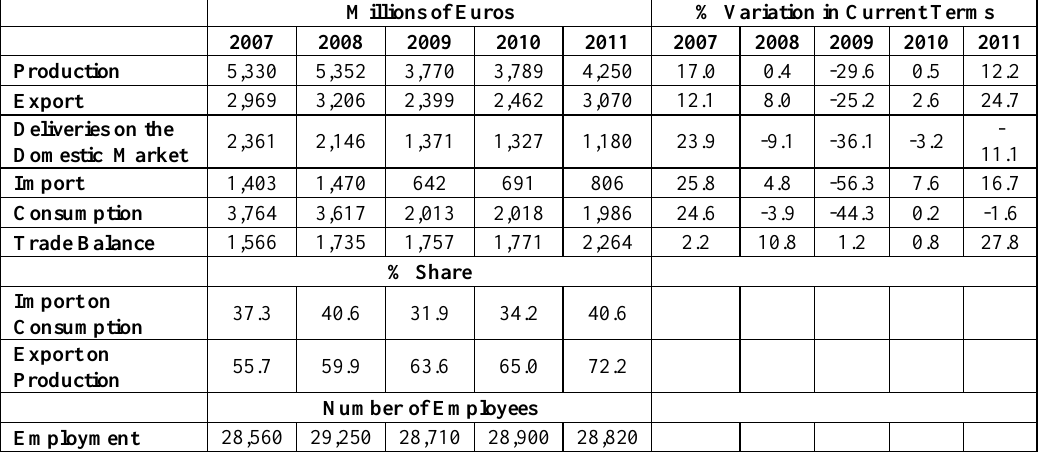
Table 1: Machine Tool Industry in Italy (Values in Millions of Euros and Annual %